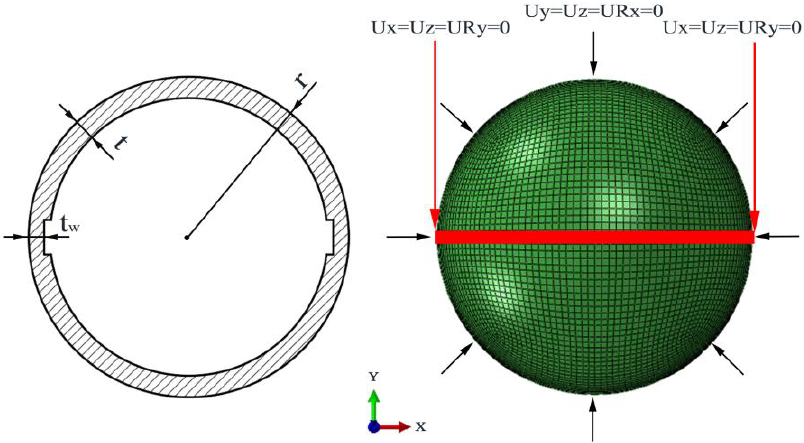
Figure 11. Finite element model of the spherical shell.